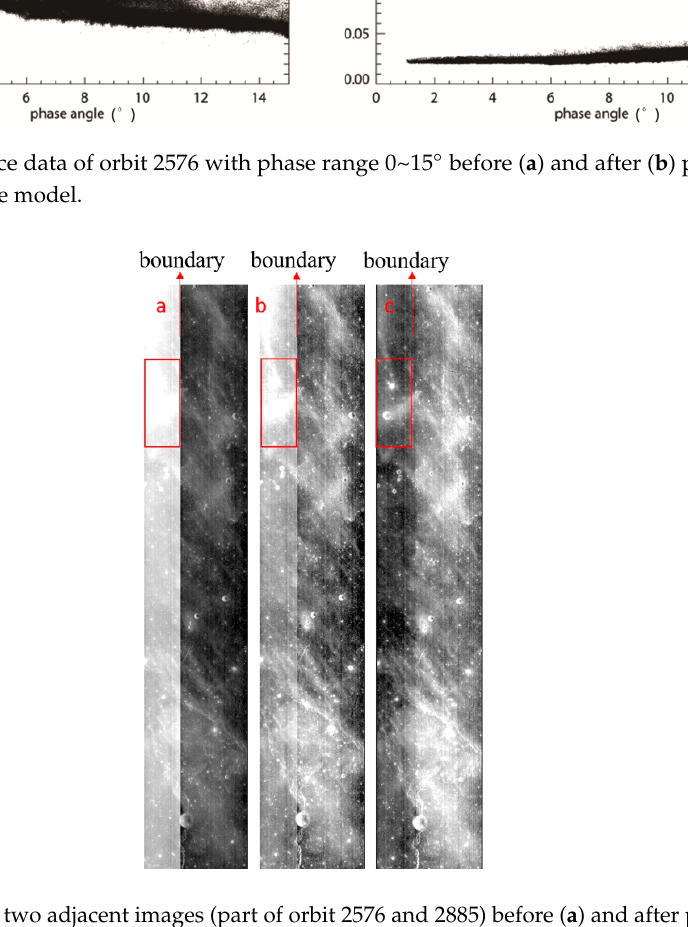
Figure 8. Mosaic of two adjacent images (part of orbit 2576 and 2885) before ( a ) and after photometric correction with empirical ( b ) and Hapke model ( c ) (In the red box, 3.73 < i < 4.89, 0.013 < e < 5.86, 2.20 < g < 6.52).